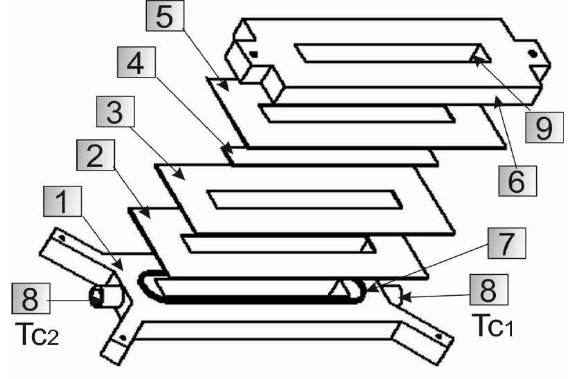
Fig. 2. The cross-section view of the test section: 1 - a front cover, 2,5 - a Teflon plate, 3 - a graphite plate, 4 - a heated plate, 6 - a channel body, 7 - an o-ring, 8 - a temperature measurement by thermocouple sensor, 9 - a glass panel.